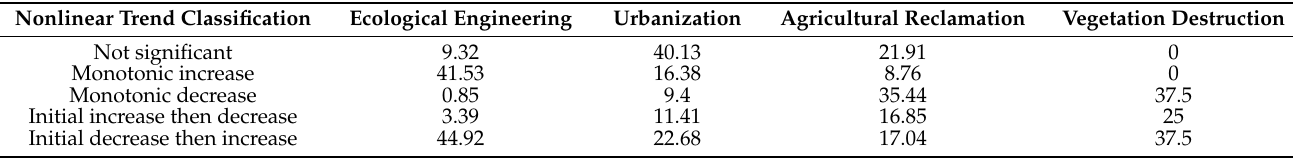
Table 8. Area percentage (%) of nonlinear trend classification of changed vegetation types. Nonlinear Trend Classification Ecological Engineering Urbanization Agricultural Reclamation Vegetation Destruction Not